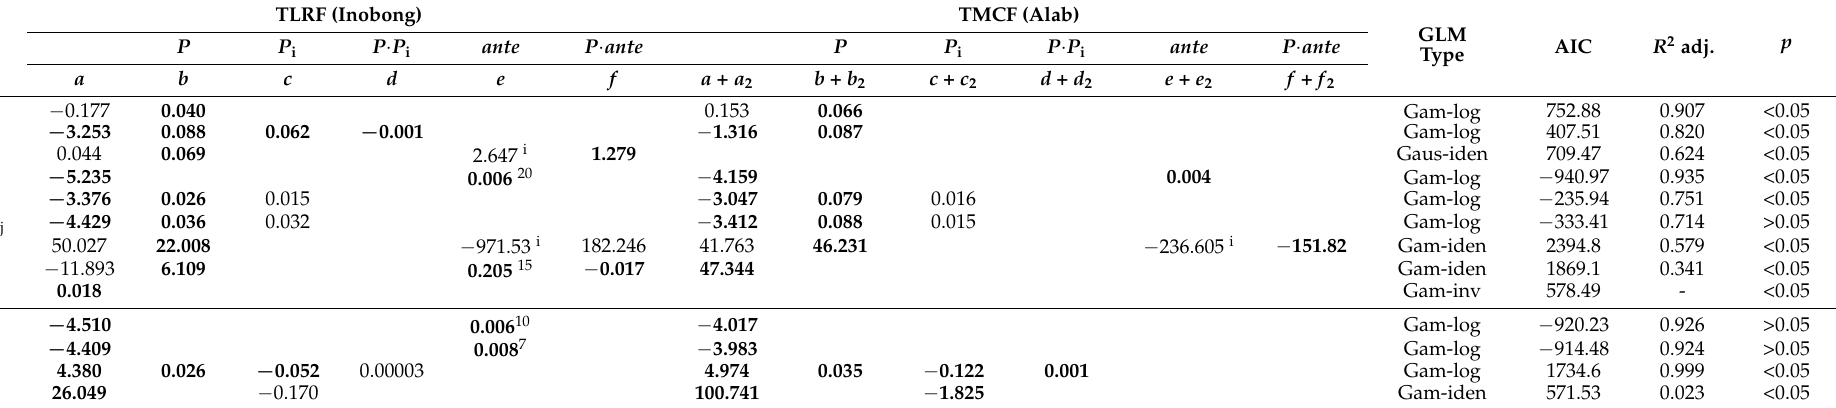
Table 4. GLM Coefficients for various response variable ( Y ) against the main predictor ( P ), secondary predictors ( P i and ante ), and forest type (1 for TMCF, 0 for TLRF) in their multivariate